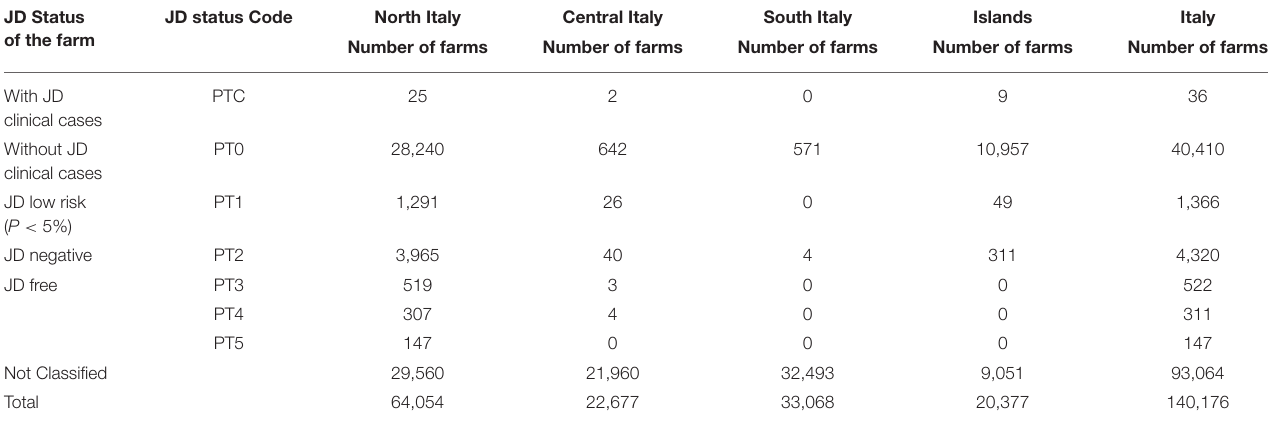
TABLE 4 | Report of the Paratuberculosis status of cattle farms, by area, Italy, 2019. JD Status of the